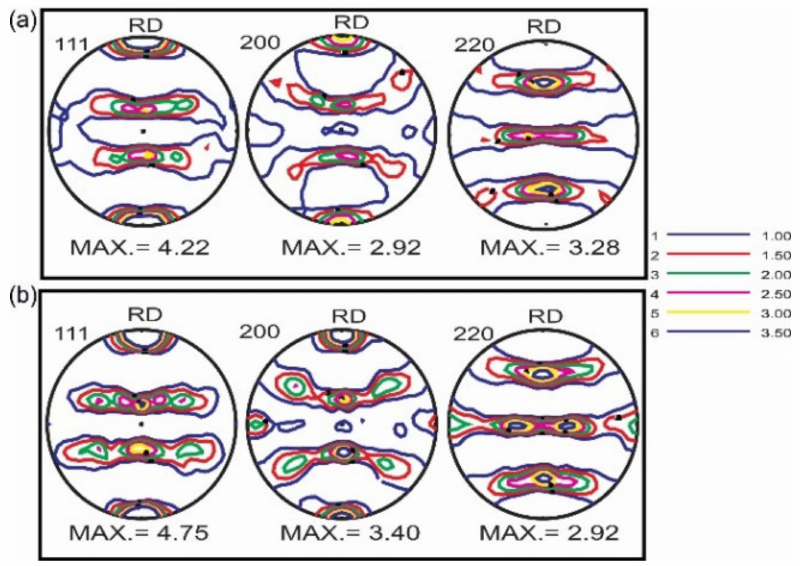
Figure 7. { 111 } , { 200 } and { 220 } PFs at the ( a ) max and ( b ) min sides of the drawn tube using +5 ◦ tilting